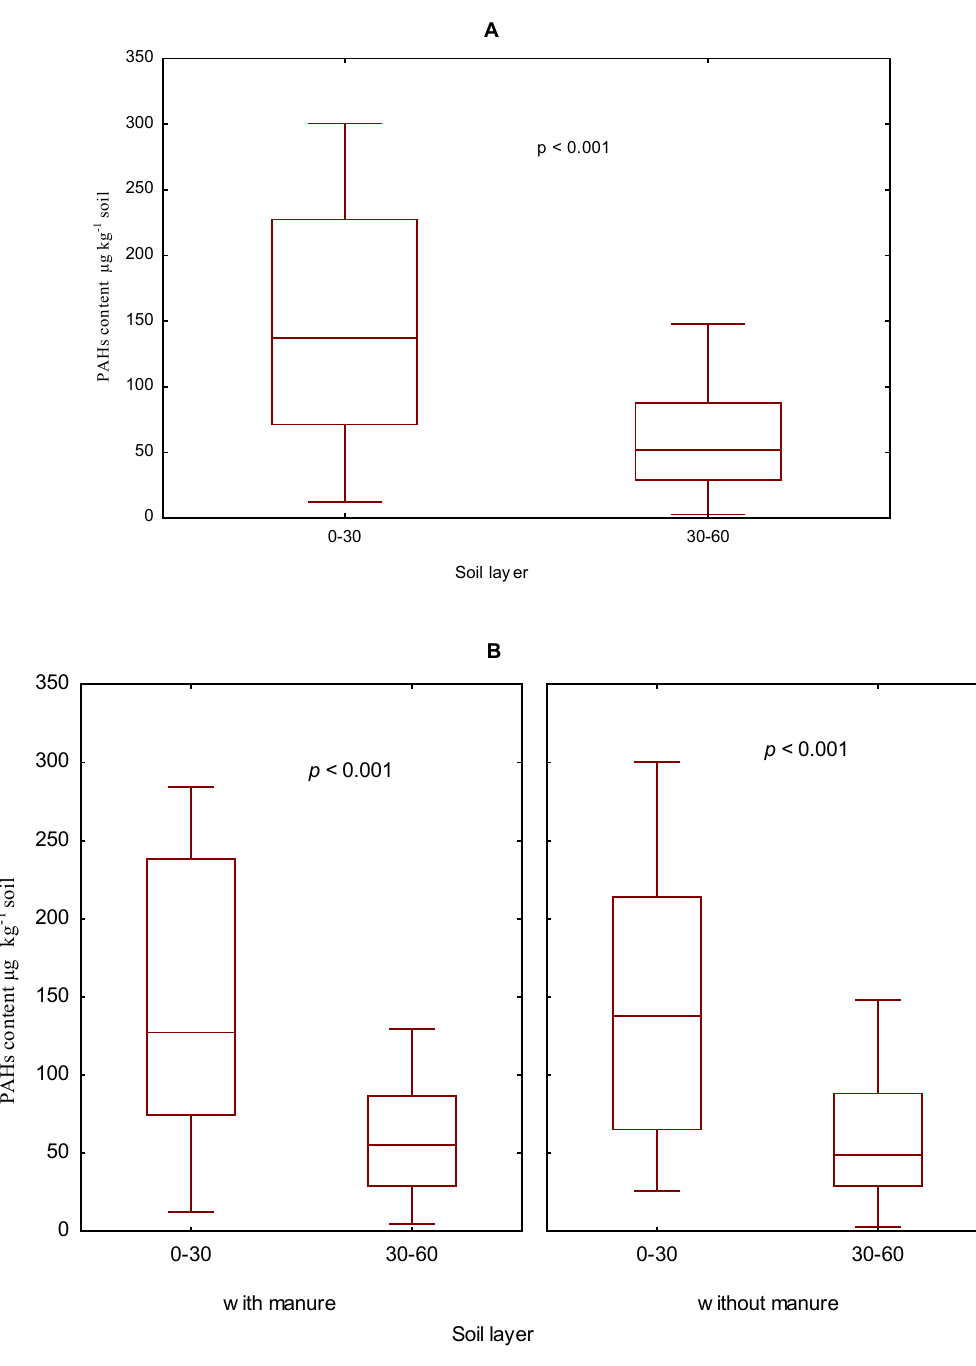
Figure 6. The content of the sum of heavy PAHs in soil in 2006–2009 depending on the soil layer ( A ). The 0–30 and 30–60 cm and manure fertilization ( B ) in µg kg − 1 . Based on the results of the statistical computations, it was demonstrated that the content of heavy PAHs in the upper soil layer was significantly higher than in the underlying, deeper soil layer, irrespective of the applied mineral fertilization (Figure 7). More detailed calculations carried out for the objects fertilized with manure or only with mineral fertilizers confirmed the above relationship, as the content of heavy PAHs was invariably higher in the upper than in the deeper soil depths, although the difference was not always verified as statistically significant in the following objects: N 0 P 0 K 0 , N 2 P 1 K 3 , N 2 P 1 K 2 Mg fer- tilized with manure and N 2 P 1 K 2 with exclusive mineral fertilization.